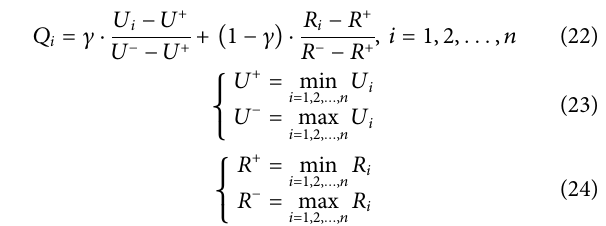
Frontiers in Energy Research |